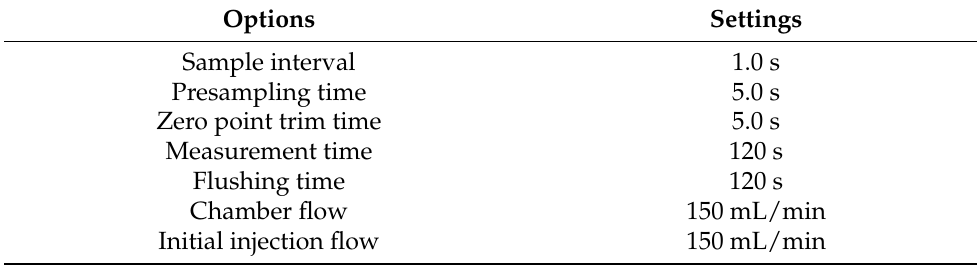
Table 2. Settings of PEN-3 electronic nose.